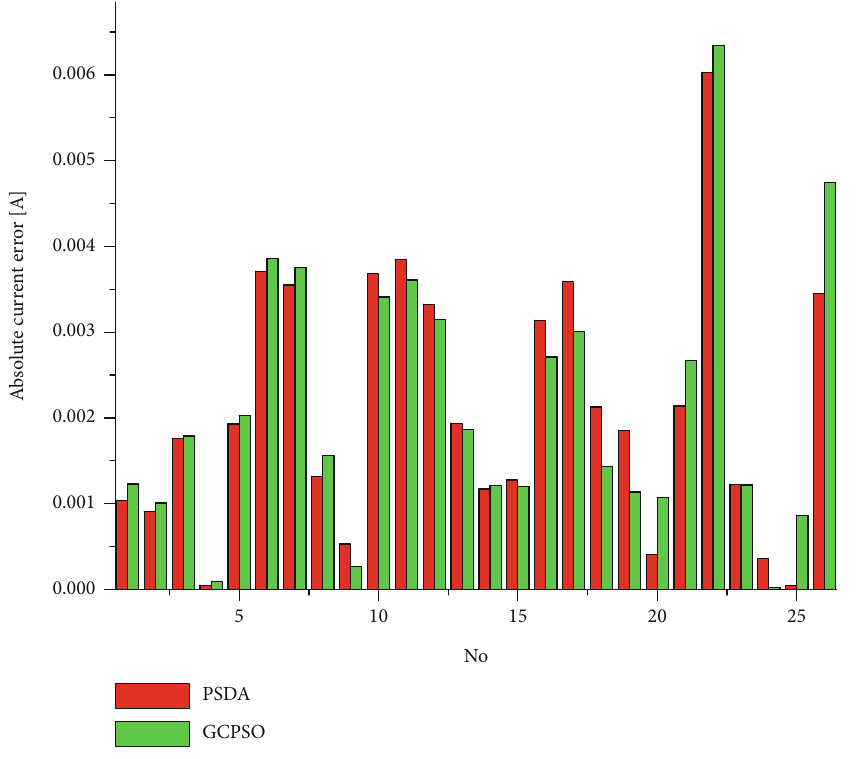
Figure 8: Absolute current error comparison for Table 3: The seven parameters of the Kyocera KC200GT photovoltaic panel.